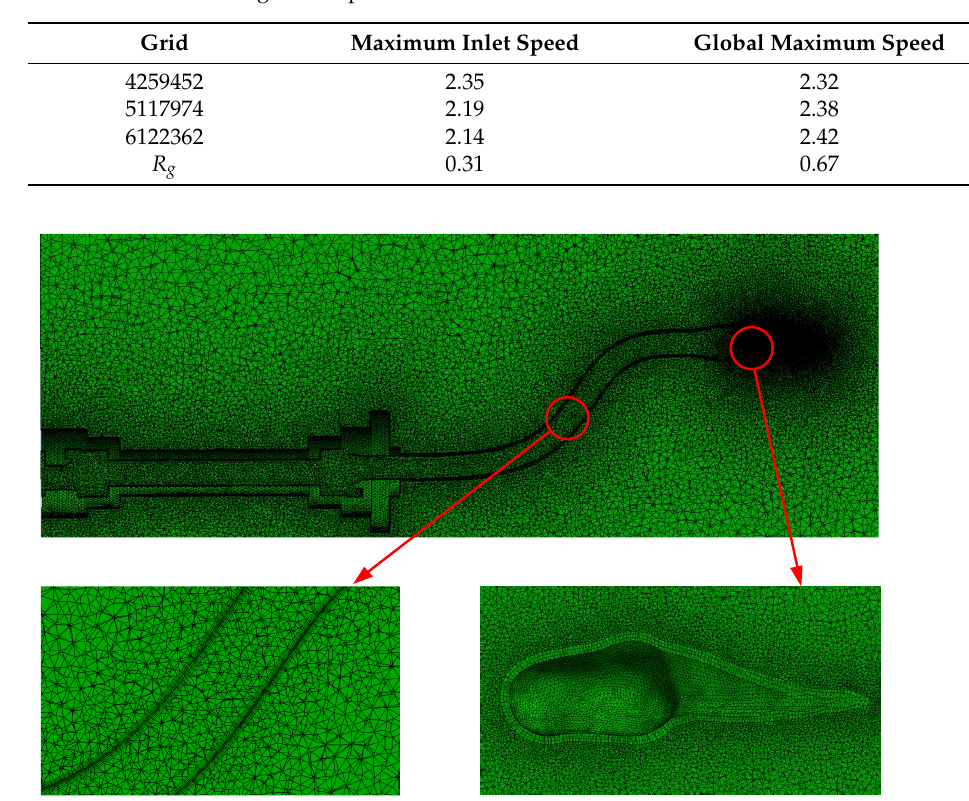
Figure 5. Model diagram of grid.